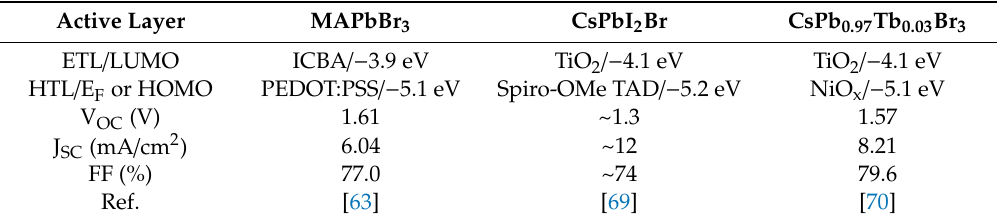
Table 2. Photovoltaic performance of bromide-based perovskite solar cells. Active